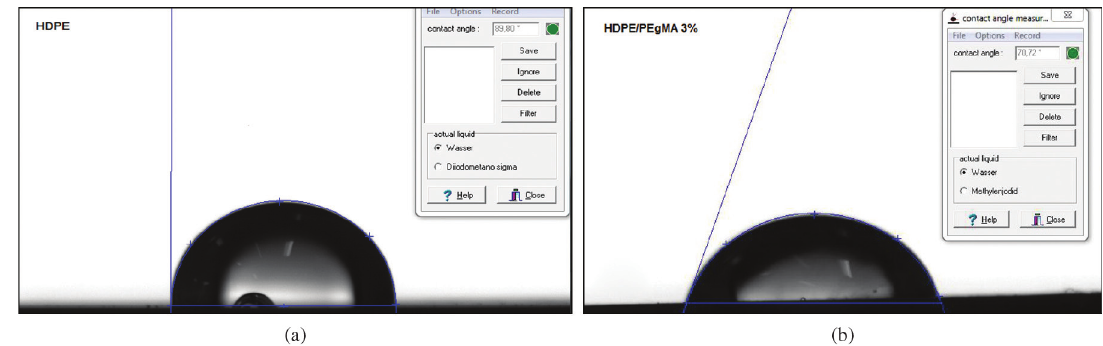
Figure 2. Image of the water drop profile on the surface of: (a) HDPE and (b) HDPE/CA